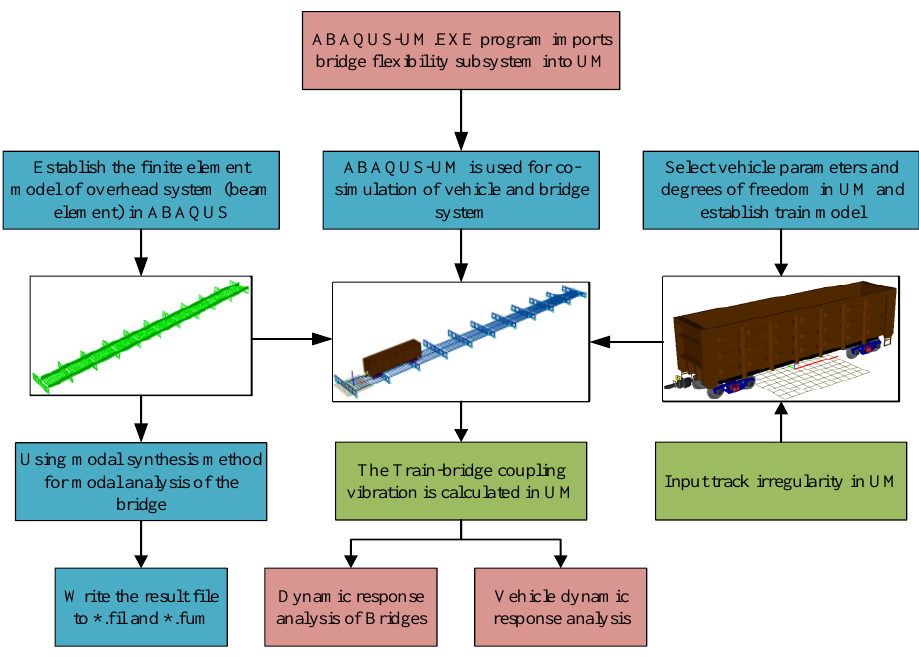
Figure 13. The process of joint